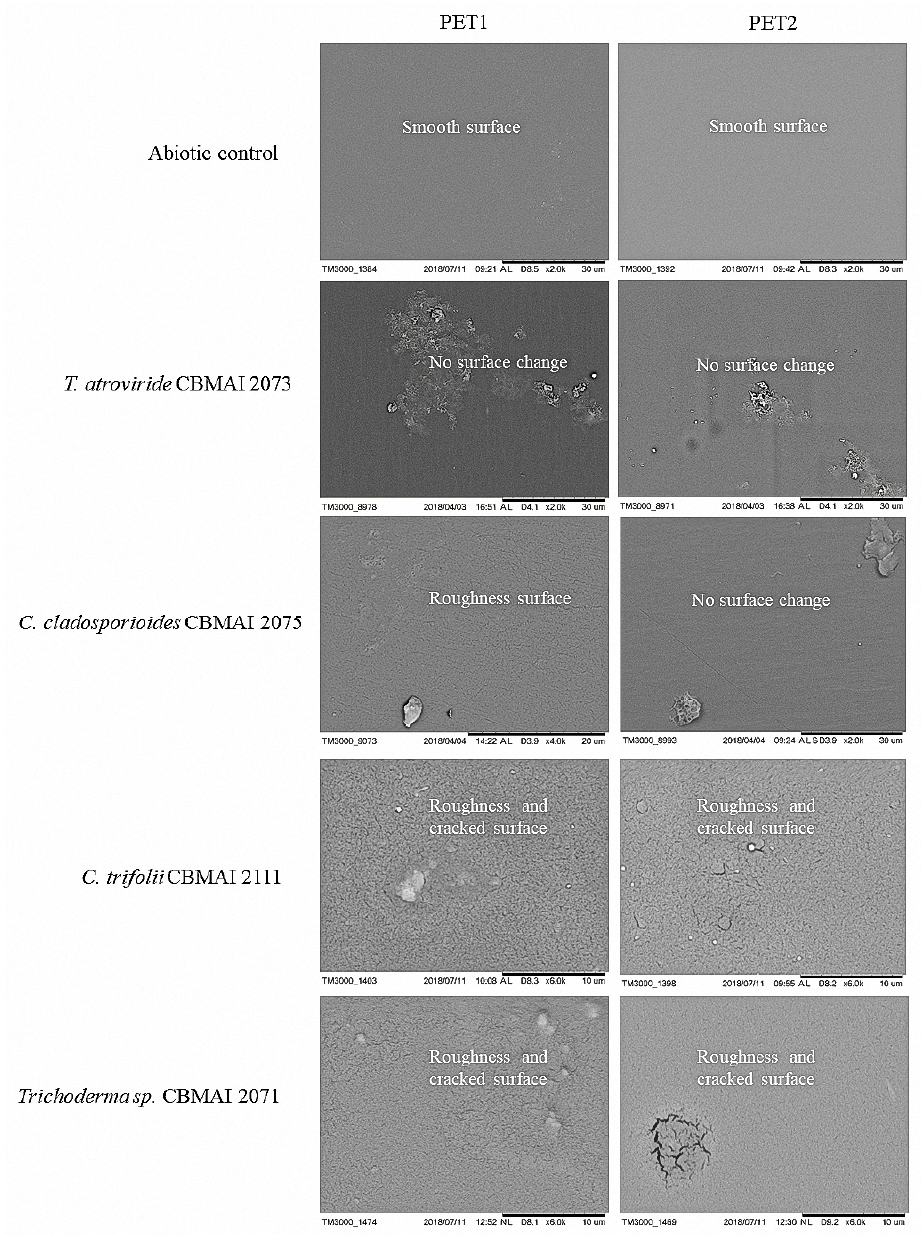
Figure 11. Scanning Electron Microscopy (SEM) demonstrating the effect of T. atroviride CBMAI 2073, C. cladosporioides CBMAI 2075, C. trifolii CBMAI 2111, and T. sp. CBMAI 2071 on PET1 and PET2 fragments compared to the abiotic control (PDB medium, no inoculum). Note. The images were obtained after cleaning the PET fragments after 40 days in PBD, 28 °C, and 150 rpm.